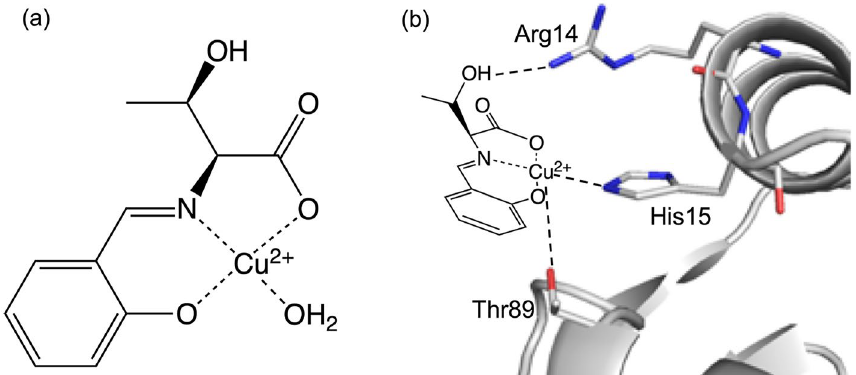
Figure 1. Schematic structures of ( a ) CuST, and ( b ) the estimated structure of the CuST-binding